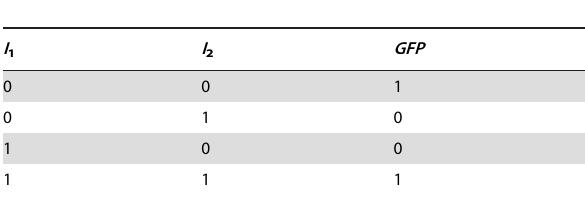
Figure 4. Examples of standard engineering designs of three cases studies. (a) Two-bit comparator (b) the three-bit adder and (c) a 3-bit parity circuit. Here the set of inputs appears indicated as open squares and the single-output element is marked as GFP. The left and right columns are different implementations of the same circuits design (Boolean table) but they have been constructed used diverse logic gates (left) or only using NAND gates with variable numbers of inputs. These circuits have been generated using the Logisim software package. Once the truth table is provided, it builds the logic circuits, either choosing the appropriate set of two-input logic gates or using just NAND gates. If the NAND gates were chosen such that they only include two inputs, the circuits would be much more complex. doi:10.1371/journal.pone.0081248.g004 Table 3. Truth table for a Two-bits magnitude